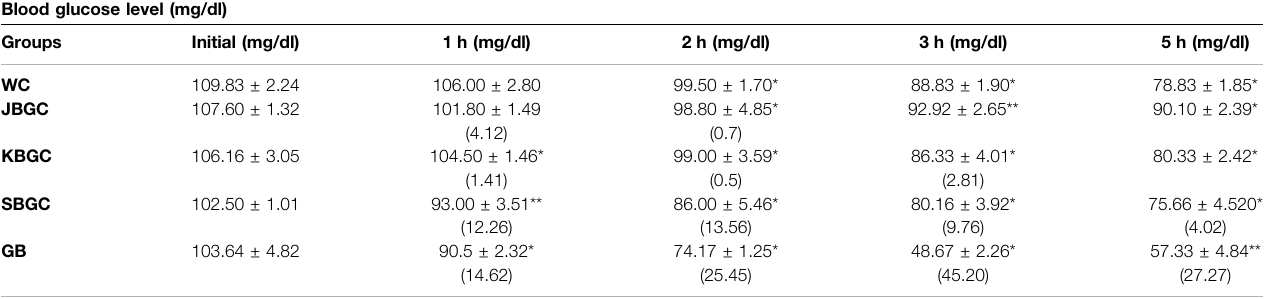
TABLE 1 | Effect of JBGC, KBGC and SBGC on blood sugar level in normal overnight fasted Swiss albino mice at various time intervals. Blood glucose level (mg/dl) Groups